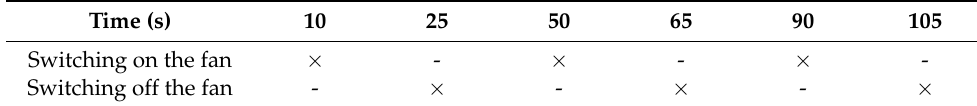
Table 2. The times of switching on/off the fan in experiment 2. Time (s)